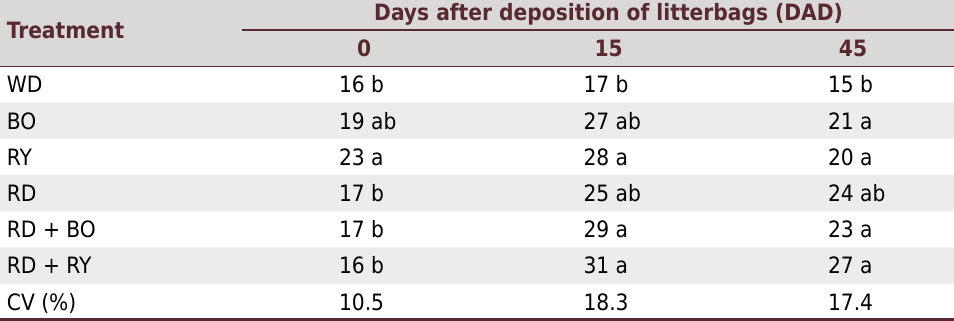
Table 4. Carbon/nitrogen ratio of remaining dry matter from the residues of weed (WD), black oat (BO), rye (RY), oilseed radish (RD), oilseed radish + black oat (RD + BO), and oilseed radish + rye (RD + RY) deposited on the onion row